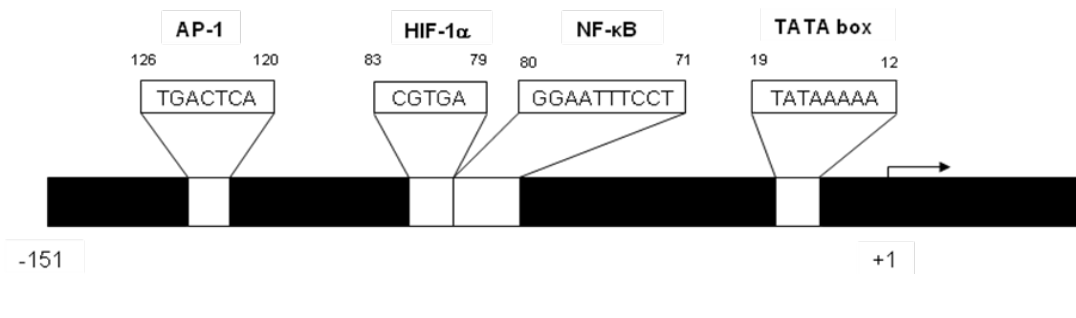
Figure 1. Schematic diagram illustrating the potential mechanisms that can underpin transcription of the IL-8